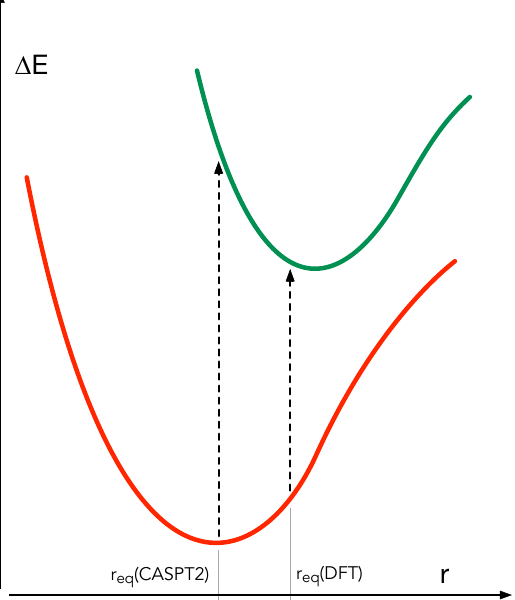
Figure 7. Schematic CASPT2 energy profiles of two electronic states as function of the Fe-ligand distance r